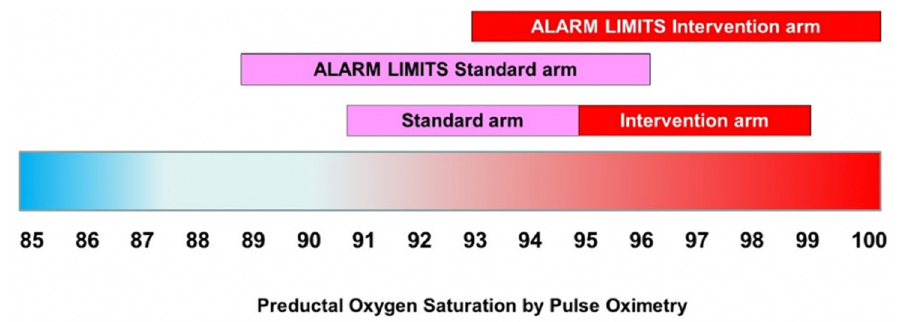
Figure 8. Oxygen saturation target and alarm limits for standard arm and intervention arm. Copy- right Satyan